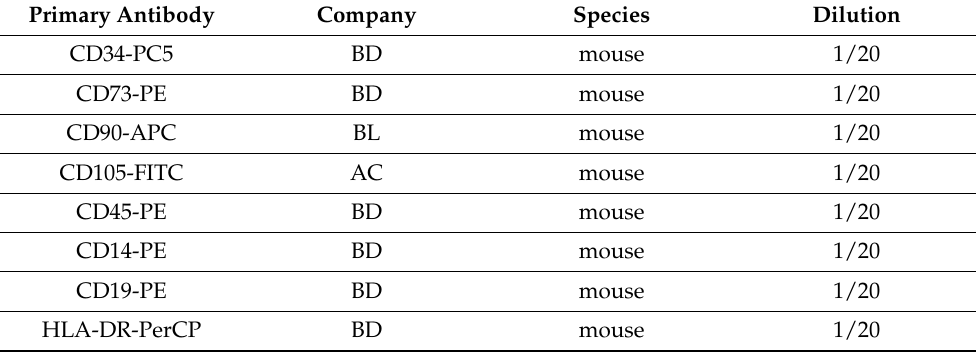
Table 1. List of